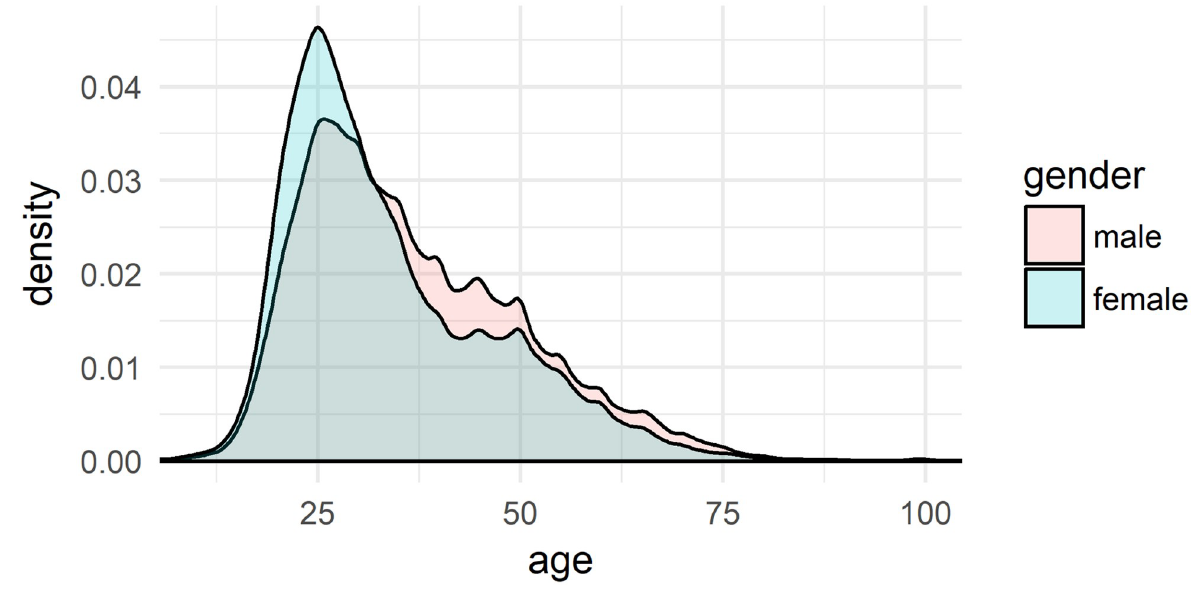
Fig 2. Density distribution of users by age and